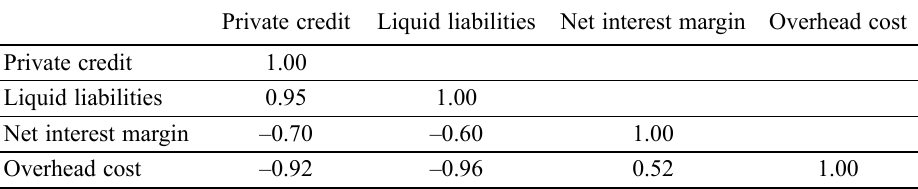
Table 2A. Correlation matrix of banking sector development indicators